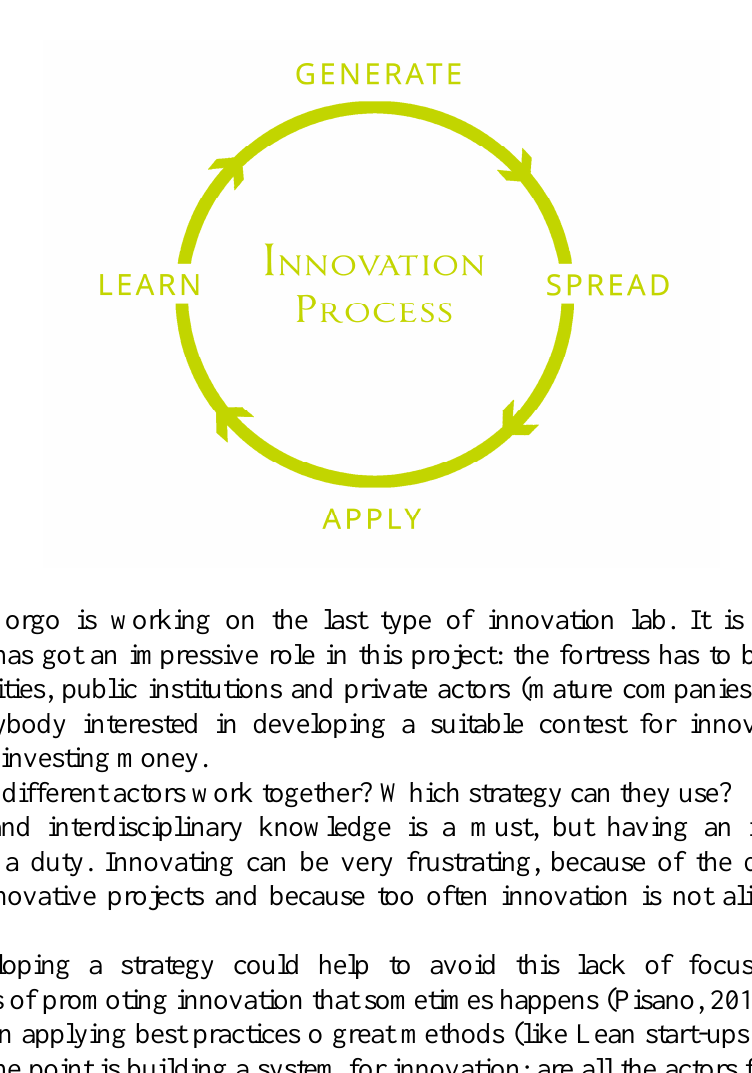
Figure 1: Innovation